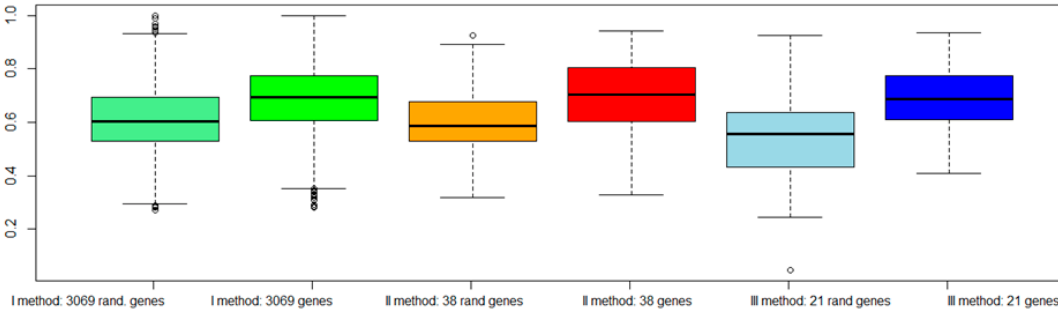
Figure 6. AUC values among three different approaches with dataset TCGA, considering also a subset of random genes. The light green box represents AUC with 3069 random genes, and the dark green box AUC with 3069 genes according to our approach. The orange box represents AUC with 38 random genes, and the red box AUC with 38 genes according to our approach. The light blue box represents AUC with 21 random genes, and the dark blue box AUC with 21 genes according to our approach.